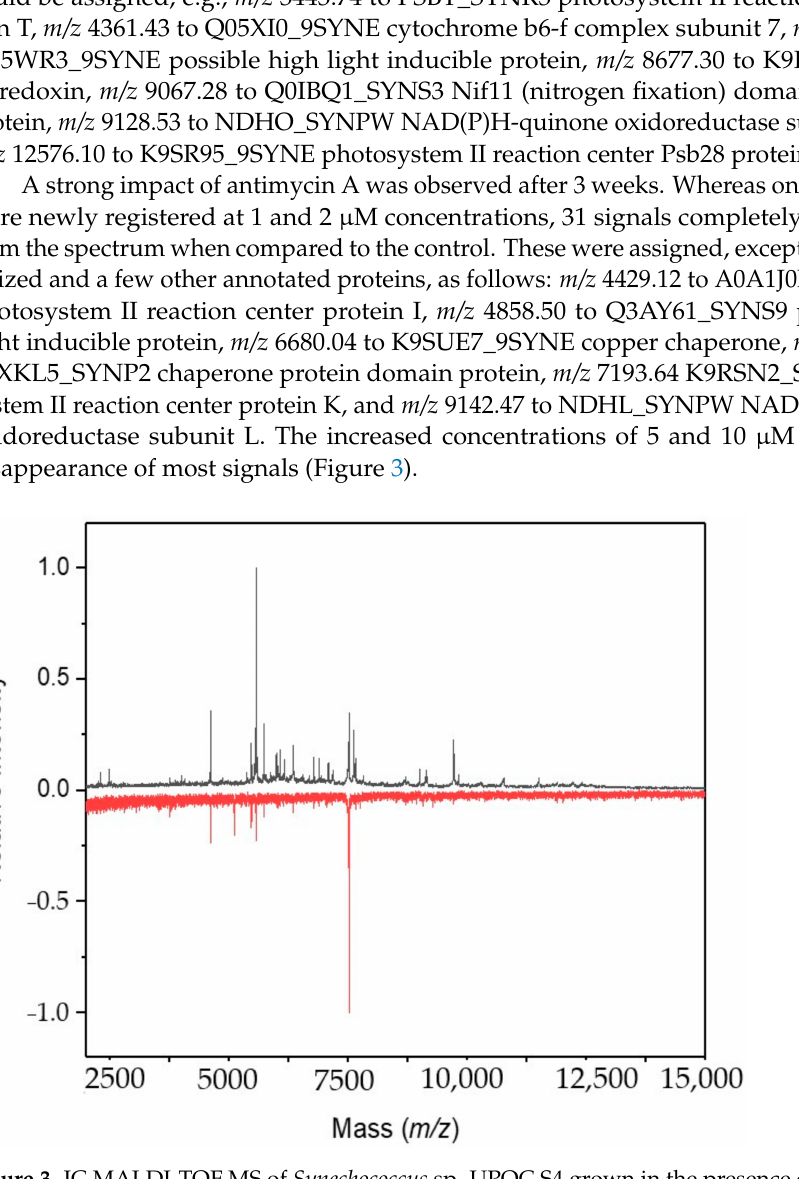
Figure 3. IC MALDI-TOF MS of Synechococcus sp. UPOC S4 grown in the presence of antimycin A. The mass spectra refer to the control and sample (cultivated in the presence of 10 µ M antimycin A for 3 weeks) and were acquired on Microflex LRF20 MALDI-TOF instrument using the dried-droplet sample preparation technique with FASA binary matrix; top spectrum in black—control; bottom spectrum in red—treated cells (intensities are multiplied by − 1 for